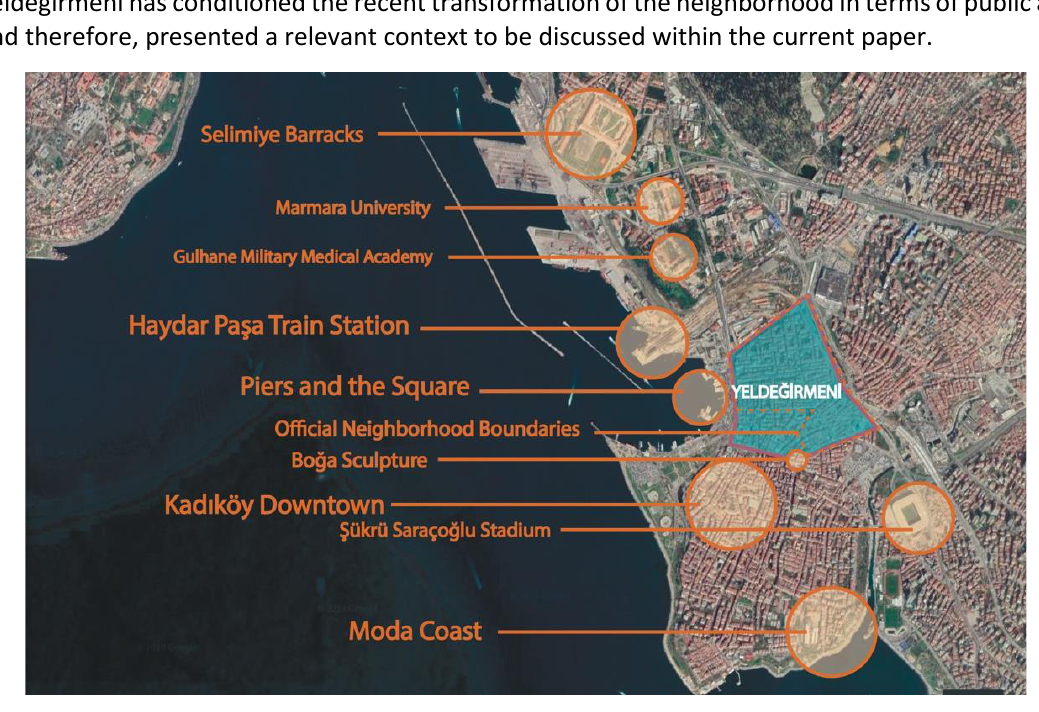
Figure 6 Location of the site in Kadıköy District, İstanbul,